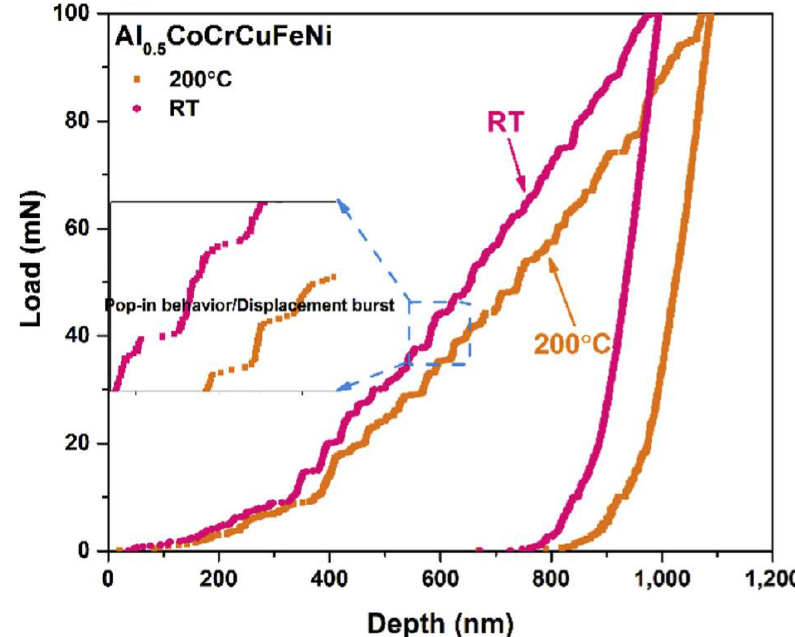
Figure 18. Nanoindentation pop-in behavior of the Al 0.5 CoCrCuFeNi HEA tested at room temperature (RT) and 200 °C (reproduced from Reference [157] with permission).